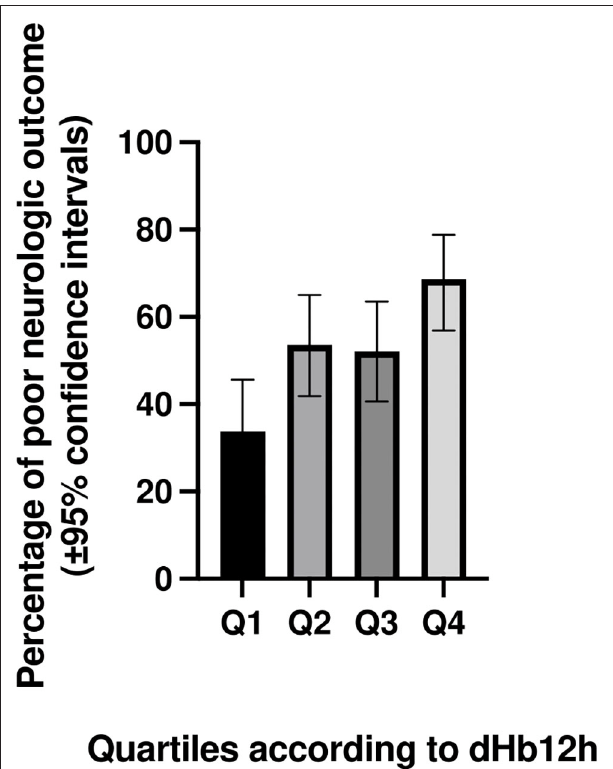
FIGURE 4 | Percentage (with 95% confidence intervals) of poor neurologic function at day 30 according to dHb12h quartiles in patients successfully resuscitated from cardiac arrest. dHb12h = Hemoglobin (Hb) levels 12h after return of spontaneous circulation—Hb levels on